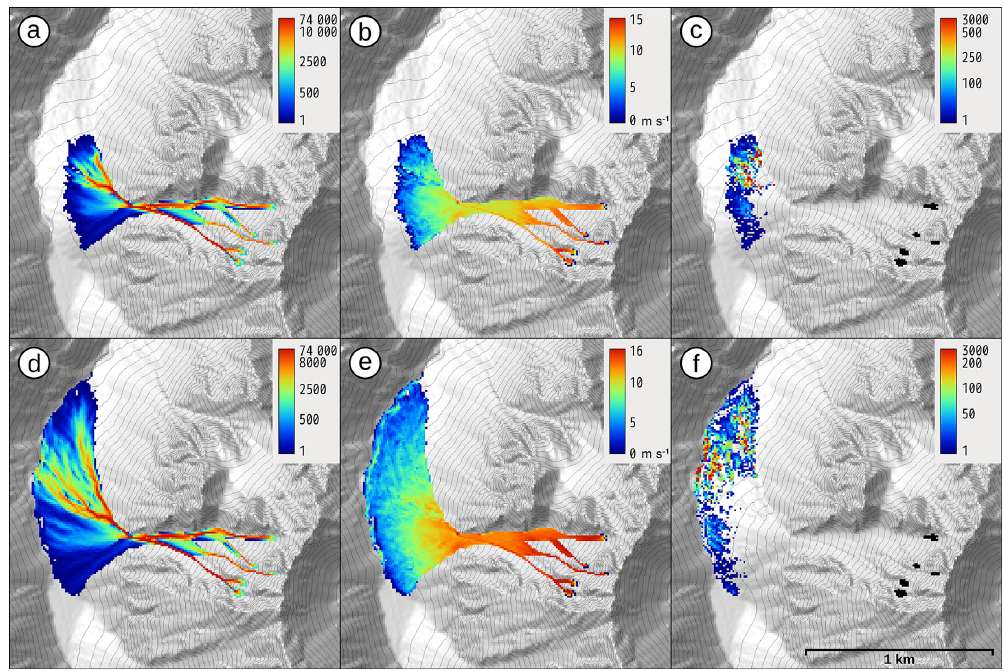
Figure 7. Medium (a–c) and large (d–f) debris flow events: (a) and (d) transition frequencies, (b) and (e) maximum velocities, and (c) and (f) stopping positions. For details see text.